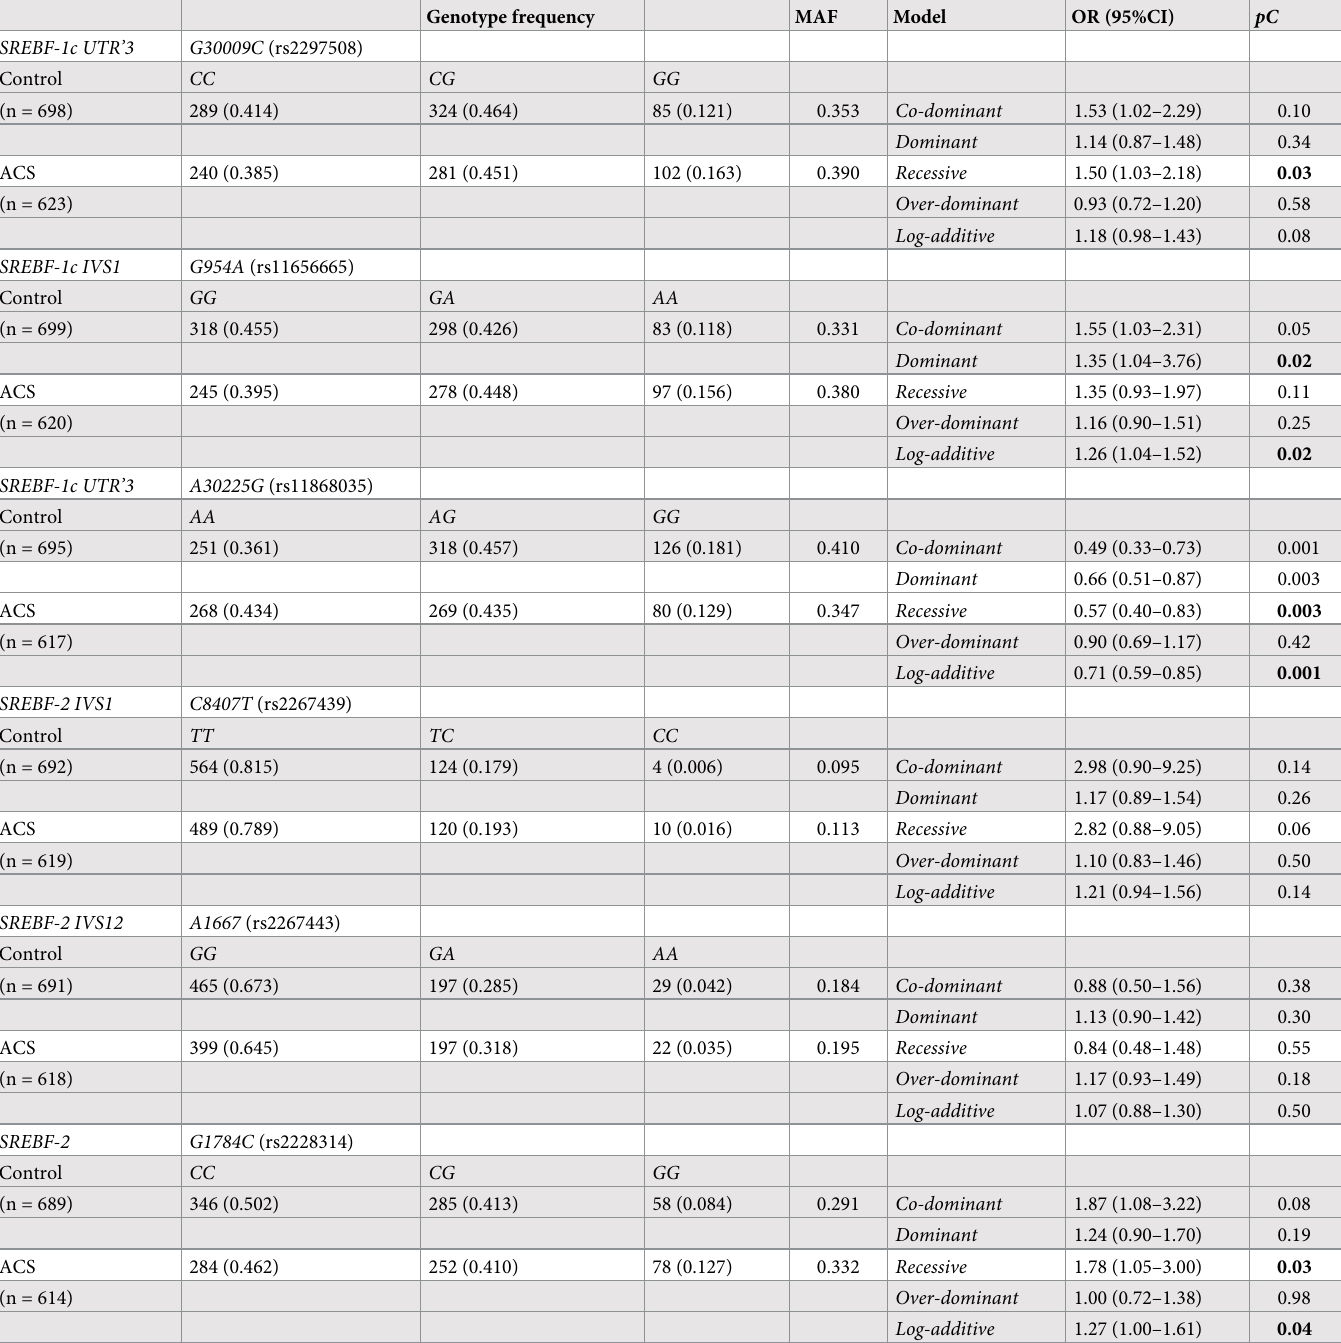
Table 2. Distribution of SREBF-1c and SREBF-2 polymorphisms in ACS patients and healthy